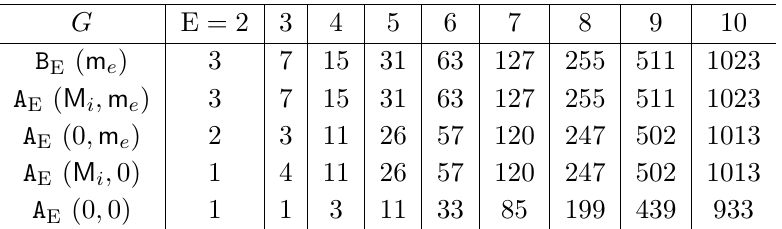
Table 2. Signed Euler characteristic | χ ( X G ) | computed using the numerical code from section 5.2 for banana ( G = B E ) and one-loop diagrams ( G = A E ); see Ex.